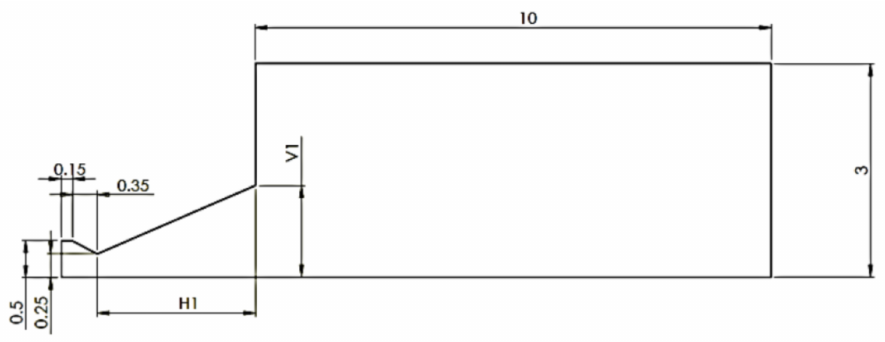
Figure 12. Conical nozzle